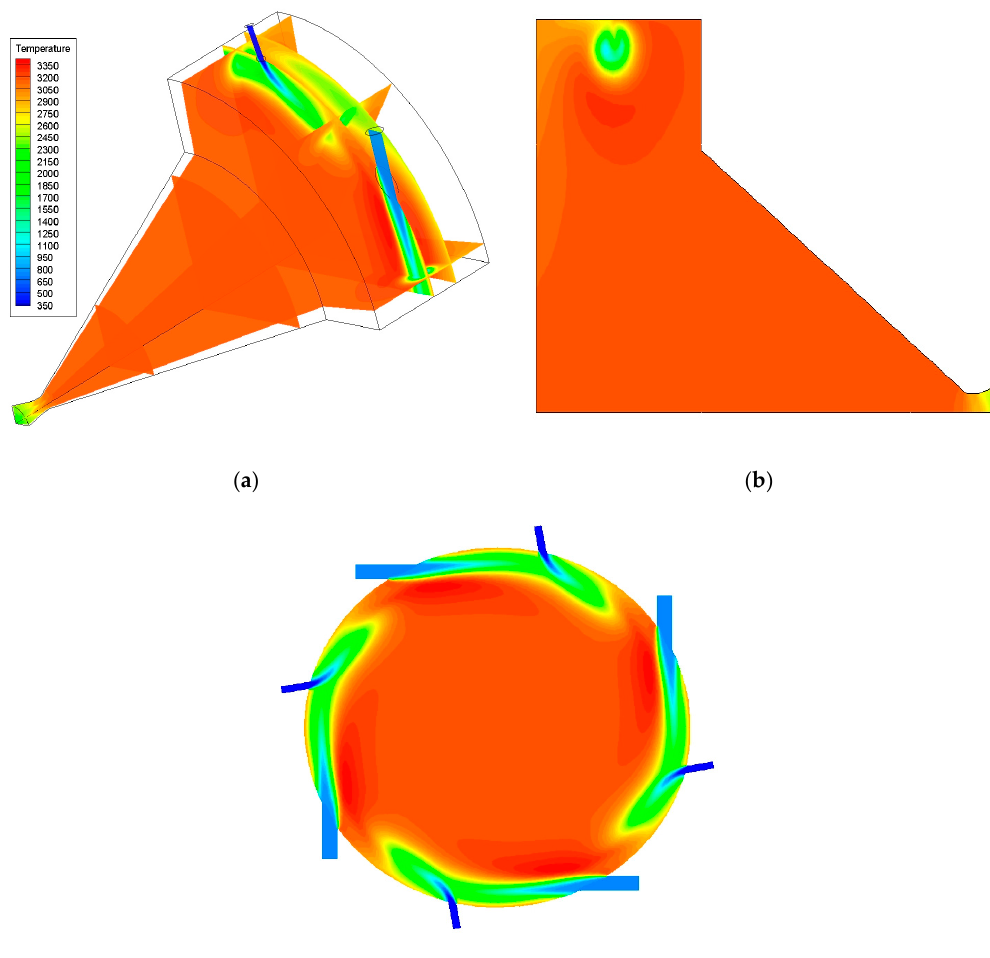
Figure 6. Temperature distribution. ( a ) 3D; ( b ) y = 0 mm; ( c ) x = 25 mm. Energies 2016 , 9 , 1072